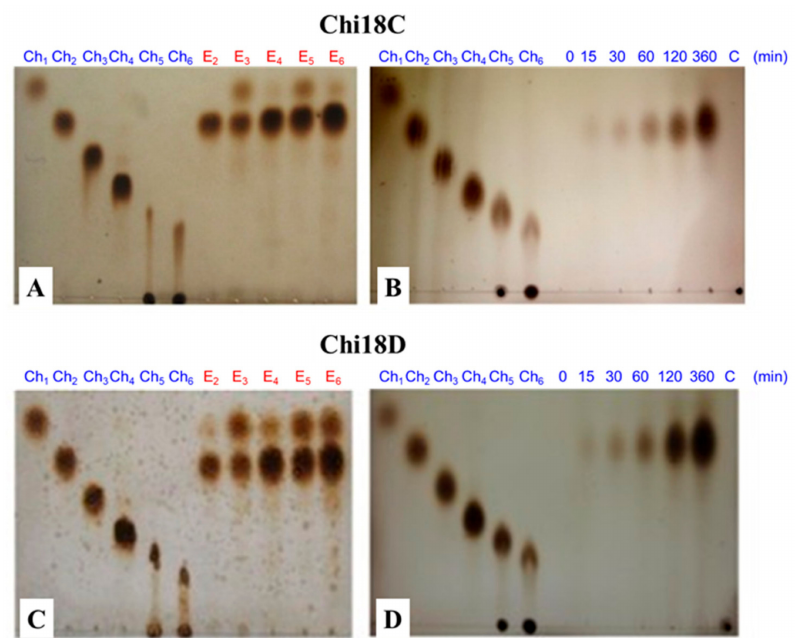
Figure 19. TLC profile of purified Chi18C ( A , B ) and Chi18D ( C , D ). TLC analysis of hydrolysis products of chitooligosaccharides ( A , C ) and colloidal chitin ( B , D ) as substrates for Chi18C and Chi18D. In ( A , C ): E 2 to E 6 , N , N ’-diacetylchitobiose (Ch 2 ) through to hexa- N -acetylchitohexaose (Ch 6 ) reacted with the enzyme. In ( B , D ): the reaction aliquots were sampled at the designated time above. The standards used were N-acetyl-D-glucosamine (Ch 1 ), N , N (cid:48) -diacetylchitobiose (Ch 2 ), N , N (cid:48) , N ”-triacetylchitotriose (Ch 3 ), tetra- N -acetylchitotetraose (Ch 4 ), penta- N -acetylchitopentaose (Ch 5 ), and hexa-N-acetylchitohexaose (Ch 6